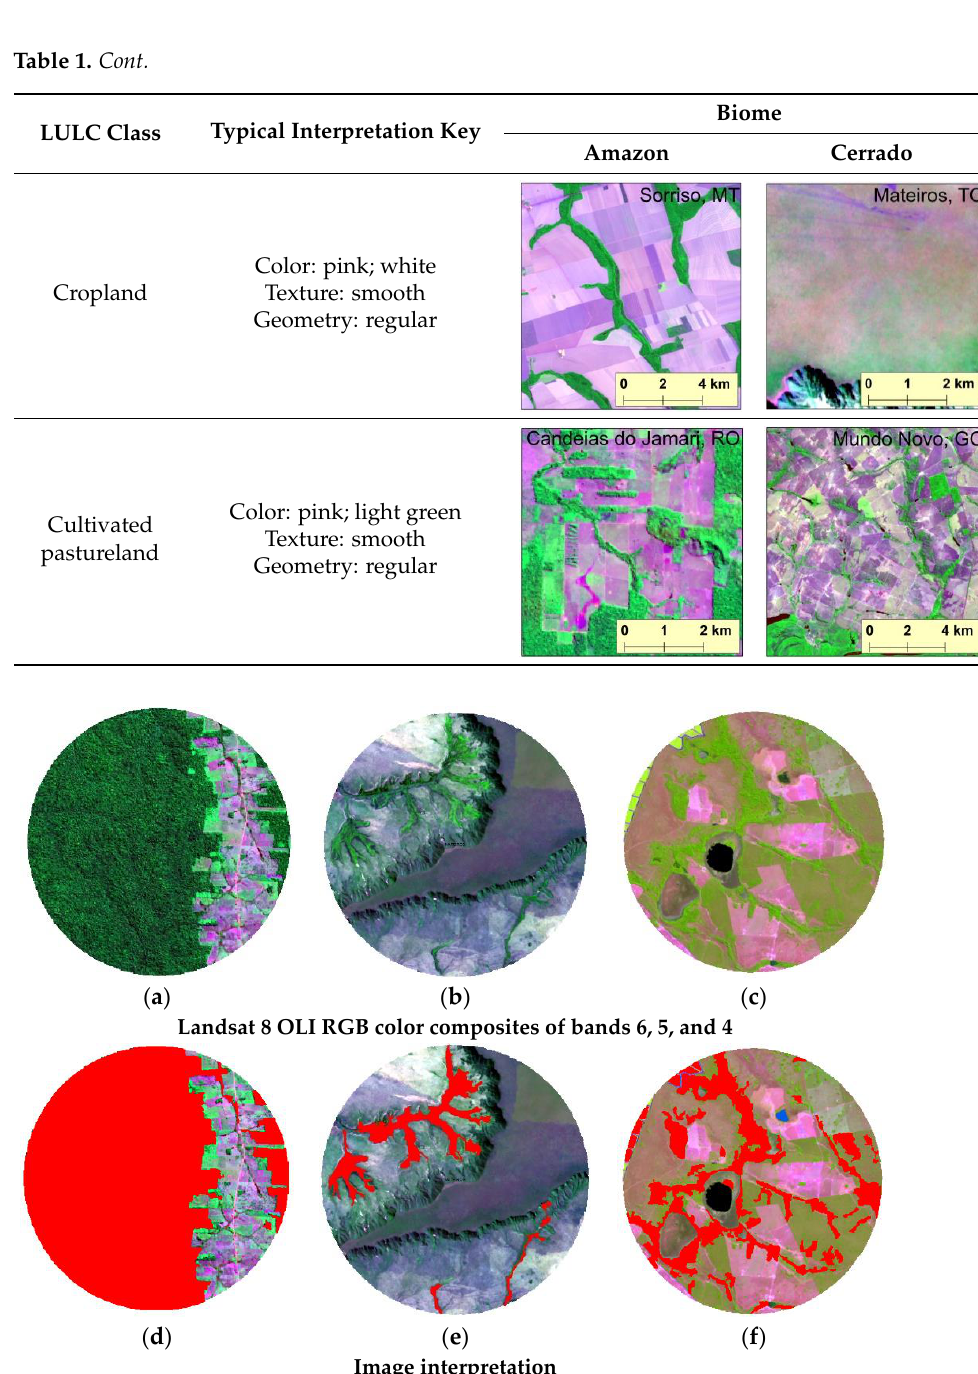
Figure 5. Examples of Landsat 8 OLI RGB color composites ( a – c ) and corresponding image interpretation ( d – f ) from the municipalities of Nova Mamoré/Rondônia (Amazon biome) and from the municipalities of Mateiros/Tocantins and São Miguel do Araguaia/Goiás (Cerrado biome), respectively. Red areas correspond to the forest class.